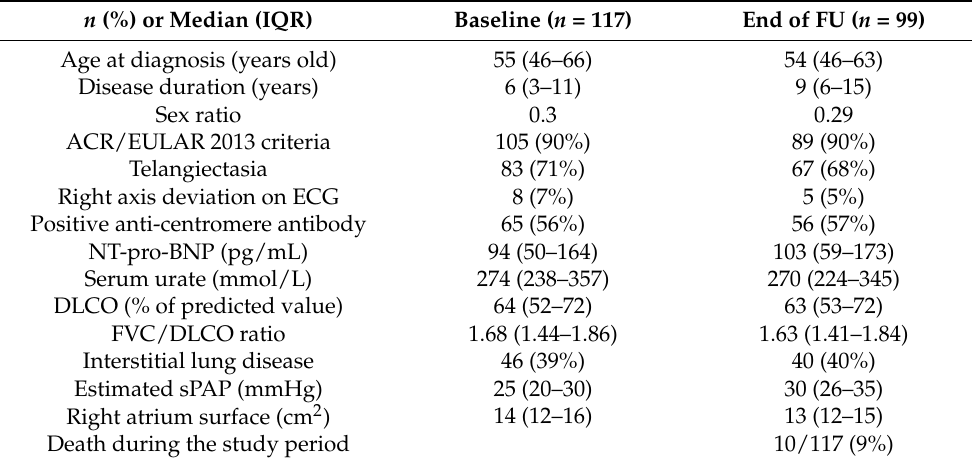
Table 1. Population characteristics at baseline and at the end of follow-up, 3 years later.